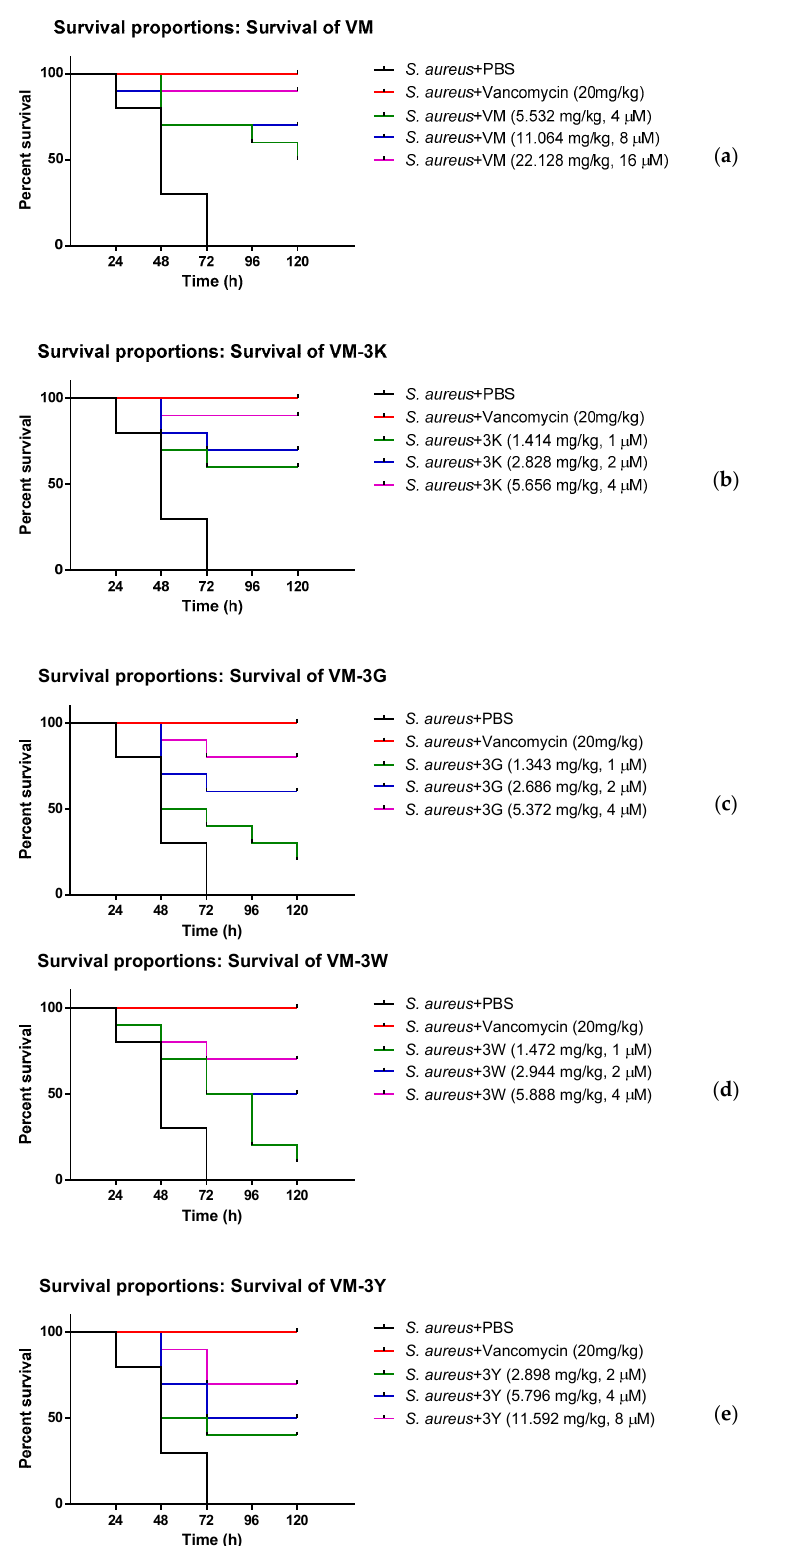
Figure 5. The survival proportions in waxworm larvae ( n = 10) infected with S. aureus and treated with ( a ) VM; ( b ) VM-3K; ( c ) VM-3G; ( d ) VM-3W; and ( e ) VM-3Y. The concentrations (mg/kg) of peptides were converted from their 1 × MIC, 2 × MIC and 4 × MIC values ( µ M). PBS and 20 mg/kg vancomycin were utilised as negative controls and positive controls, respectively.